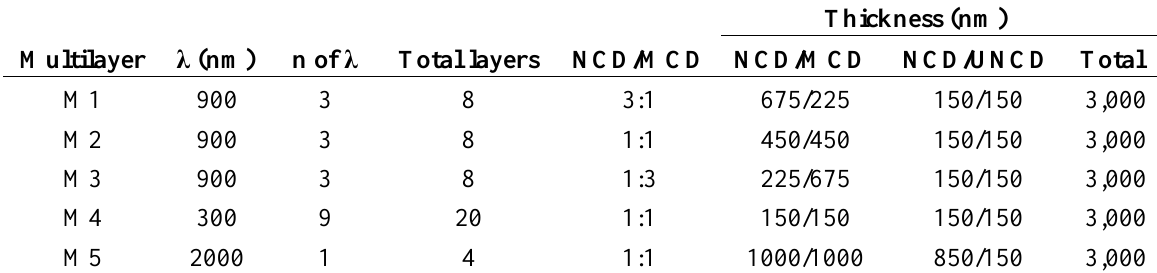
Table 1. Summary of multilayered coating parameters used in this study.